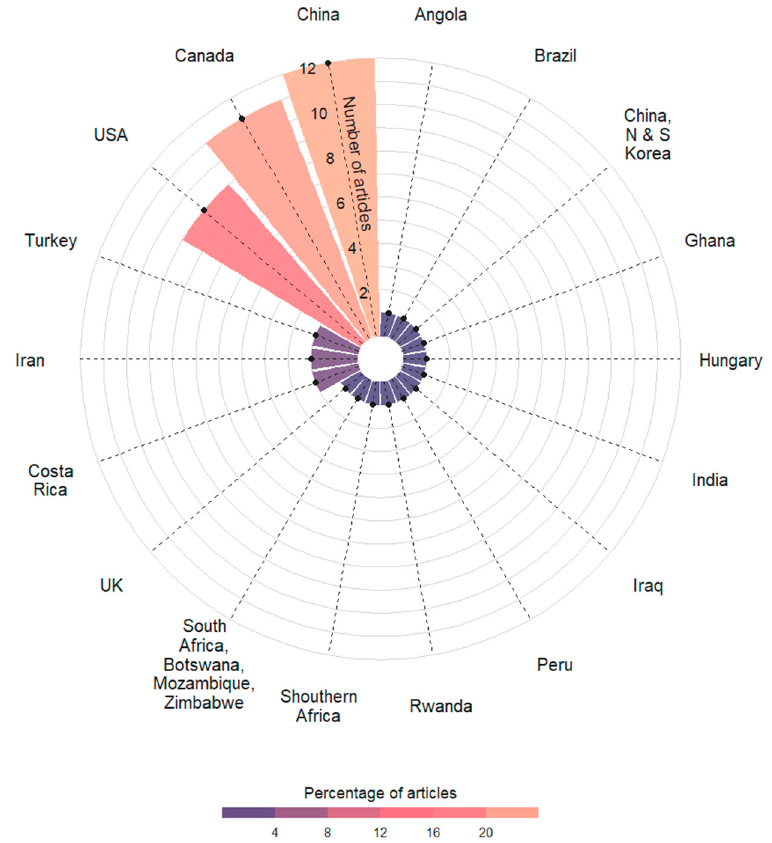
Figure 4. Number and percentage of publications per country.